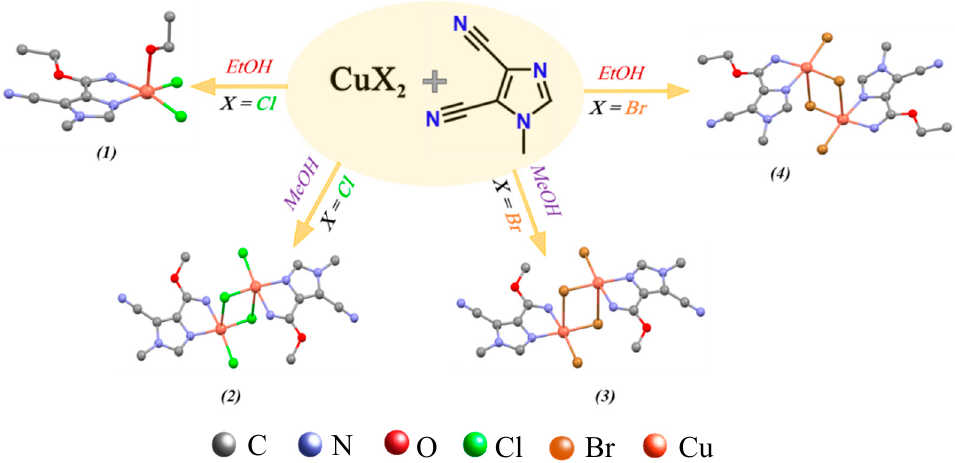
Figure 1. Formation of complexes 1 – 4 . The hydrogen atoms are omitted for clarity.